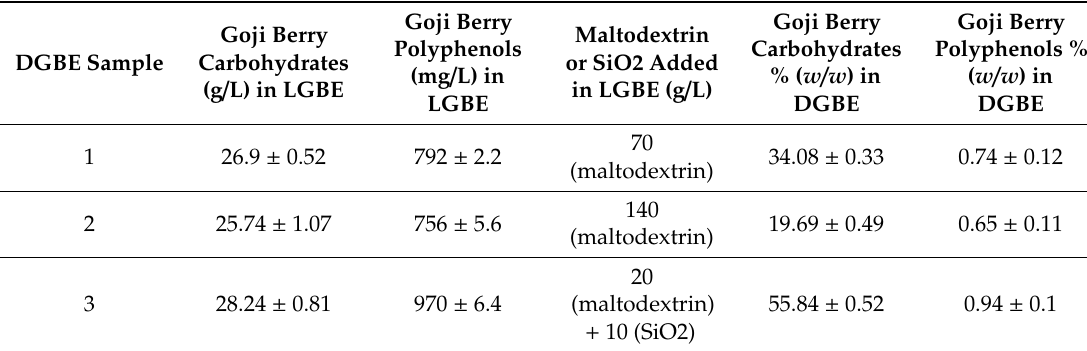
Table 1. Concentration of Goji berry polyphenols and carbohydrates in liquid and dried-encapulated Goji berry extract (LGBE and DGBE, respectively), as well as maltodextrin or SiO2 concentration added in liquid Goji berry extracts (LGBE) before encapsulation of the three samples of dried-encapsulated Goji berry powder used in this study. Goji DGBE Sample